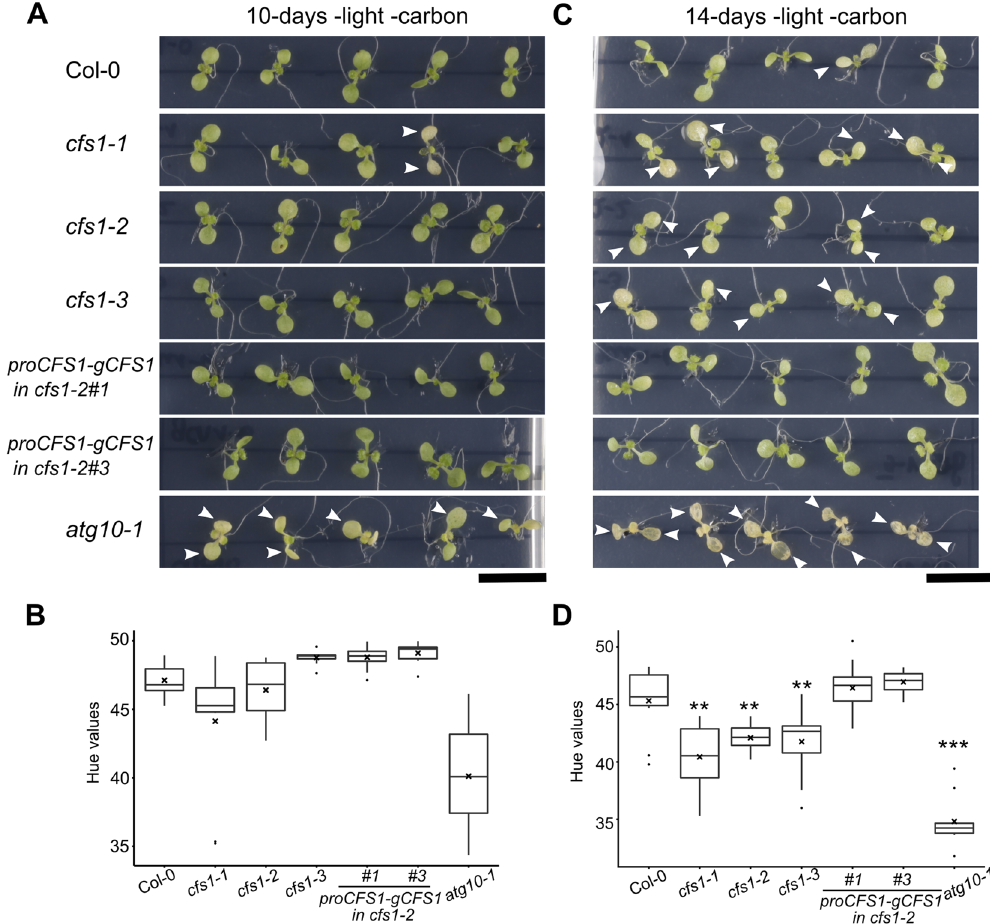
Figure 6. cfs1 mutants are hypersensitive to carbon starvation. ( A ) 7-day old seedlings subjected to 10 days of carbon starvation show no difference in yellowing between the majority of cfs1 mutants, Col-0 and the complemented lines ( proCFS1-gCFS1 in cfs1-2 #1, #3). Arrowheads indicate yellowing in the cotyledons, and atg10-1 plants were used as positive control. Scale bar: 1 cm. ( A ) Boxplots show the hue values of the cotyledons shown in ( A ). Straight line within the box represents median, mean value and outliers are depicted as cross and closed circles, respectively. ( C ) 7-day old seedlings subjected to 14 days of carbon starvation show cotyledon yellowing in the majority of cfs1 mutants compared with Col-0 and the complemented lines. The genotypes of each row are arranged as in A. Arrowheads indicate yellowing in the cotyledons, and atg10-1 plants were used as positive control. Scale bar: 1 cm. ( D ) Boxplots show the hue values of the cotyledons shown in ( C ). Straight line within the box represents median, mean value and outliers are depicted as cross and closed circles, respectively. Hue values of each genotype were compared to Col-0 using Wilcoxon rank sum test. Double asterisks indicated statistical significant difference at p ≤ 0.01 and triple asterisks at p ≤